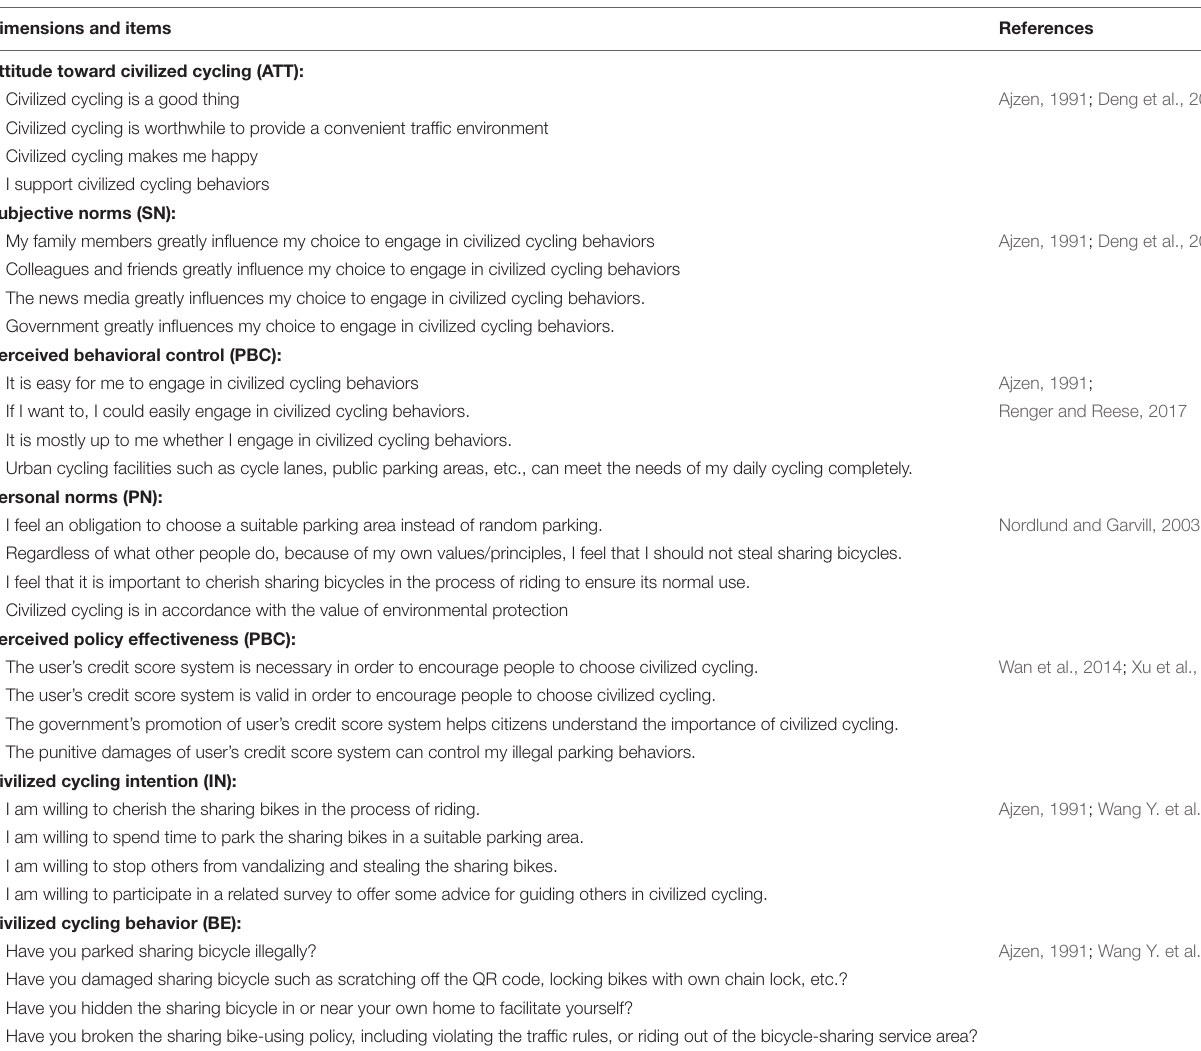
TABLE 2 | Constructs and scale